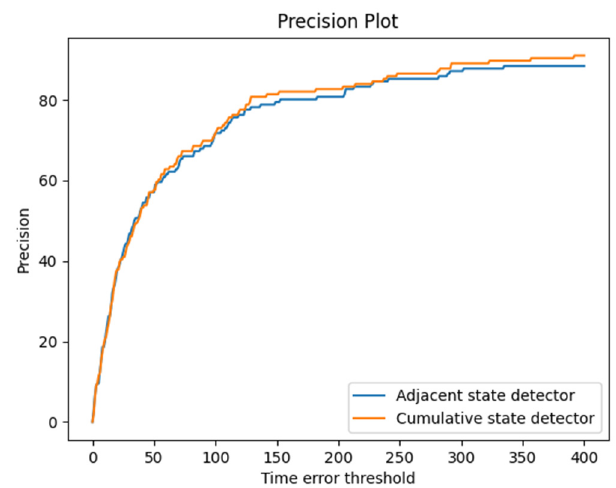
Figure 9. The precision curves of different state detectors.